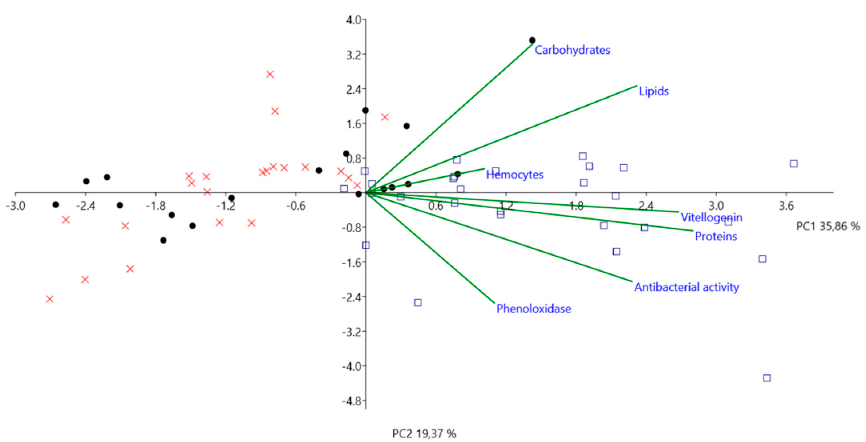
Figure 4. Principal component analysis of variances (proteins, lipids, carbohydrates, vitellogenin, antibacterial activity, phenoloxidase, and haemocytes). Component 1 (PC1) depicted as the x -axis explains 35.86% of sample variability. Component 2 (PC2) depicted as the y -axis explains 19.37% of sample variability. Black dots, red crosses, and blue squares represent values for summer 2017, summer 2018, and winter 2017 / 2018, respectively. Green lines express the extent to which each variable contributes to the explanation of the differences.